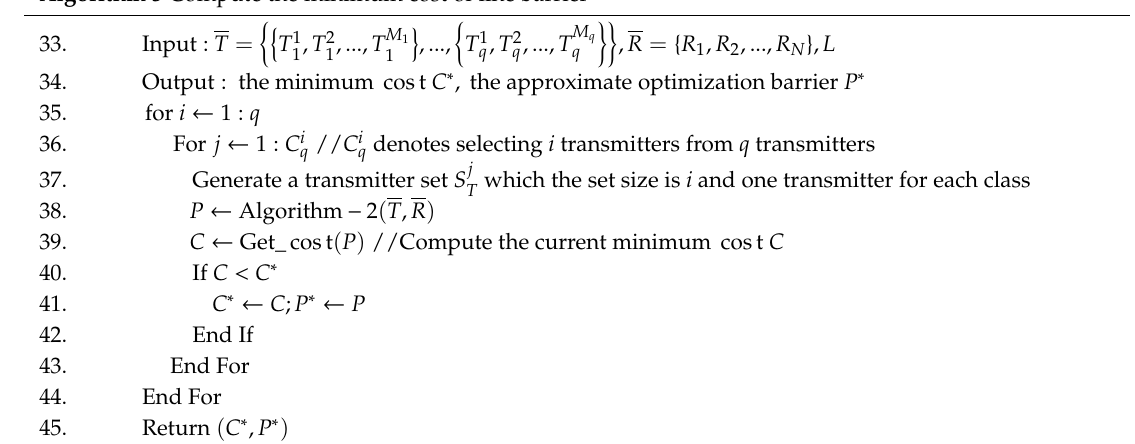
Algorithm 3 Compute the minimum cost of line